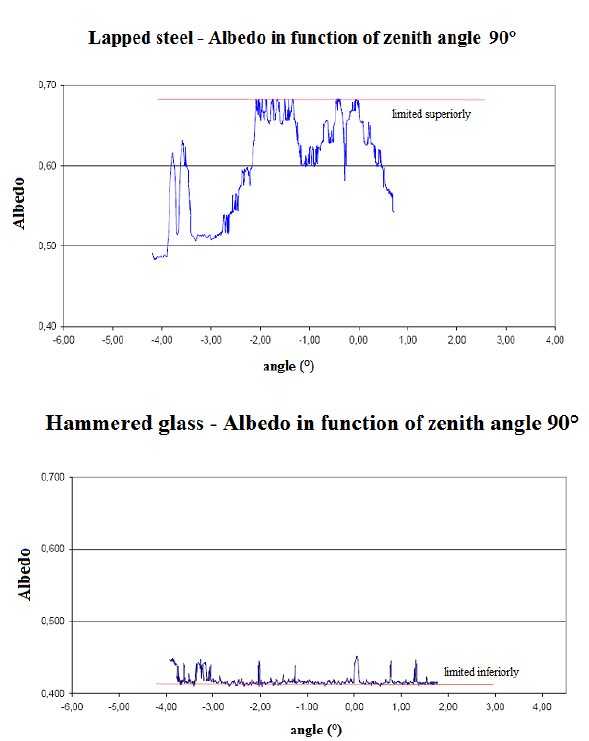
Figure 8 - Minimum values of albedo in correspondence of non- crystalline glassy materials